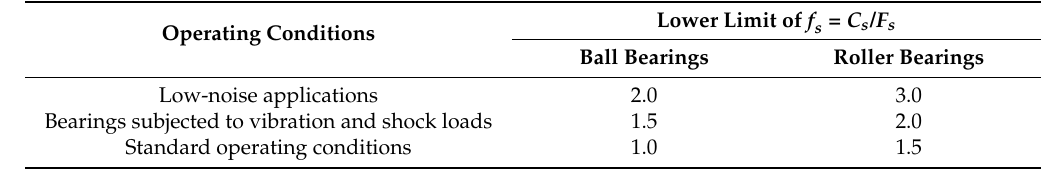
Table 3. Values of permissible static load factor fs [63].